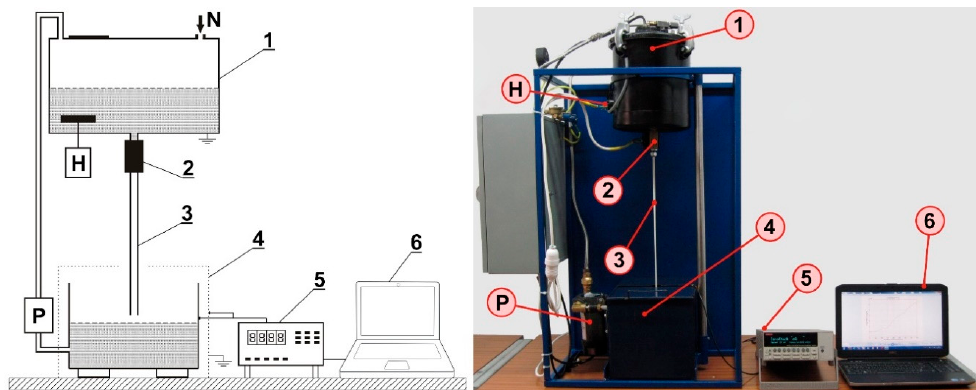
Figure 1. Flow system for the investigation of electrification current of insulation liquids: 1—upper container with liquid, 2—solenoid valve, 3—measuring pipe, 4—Faraday cage with lower container, 5—Keithley 6517A electrometer, 6—portable computer, N—nitrogen, H—heater with thermostat, and